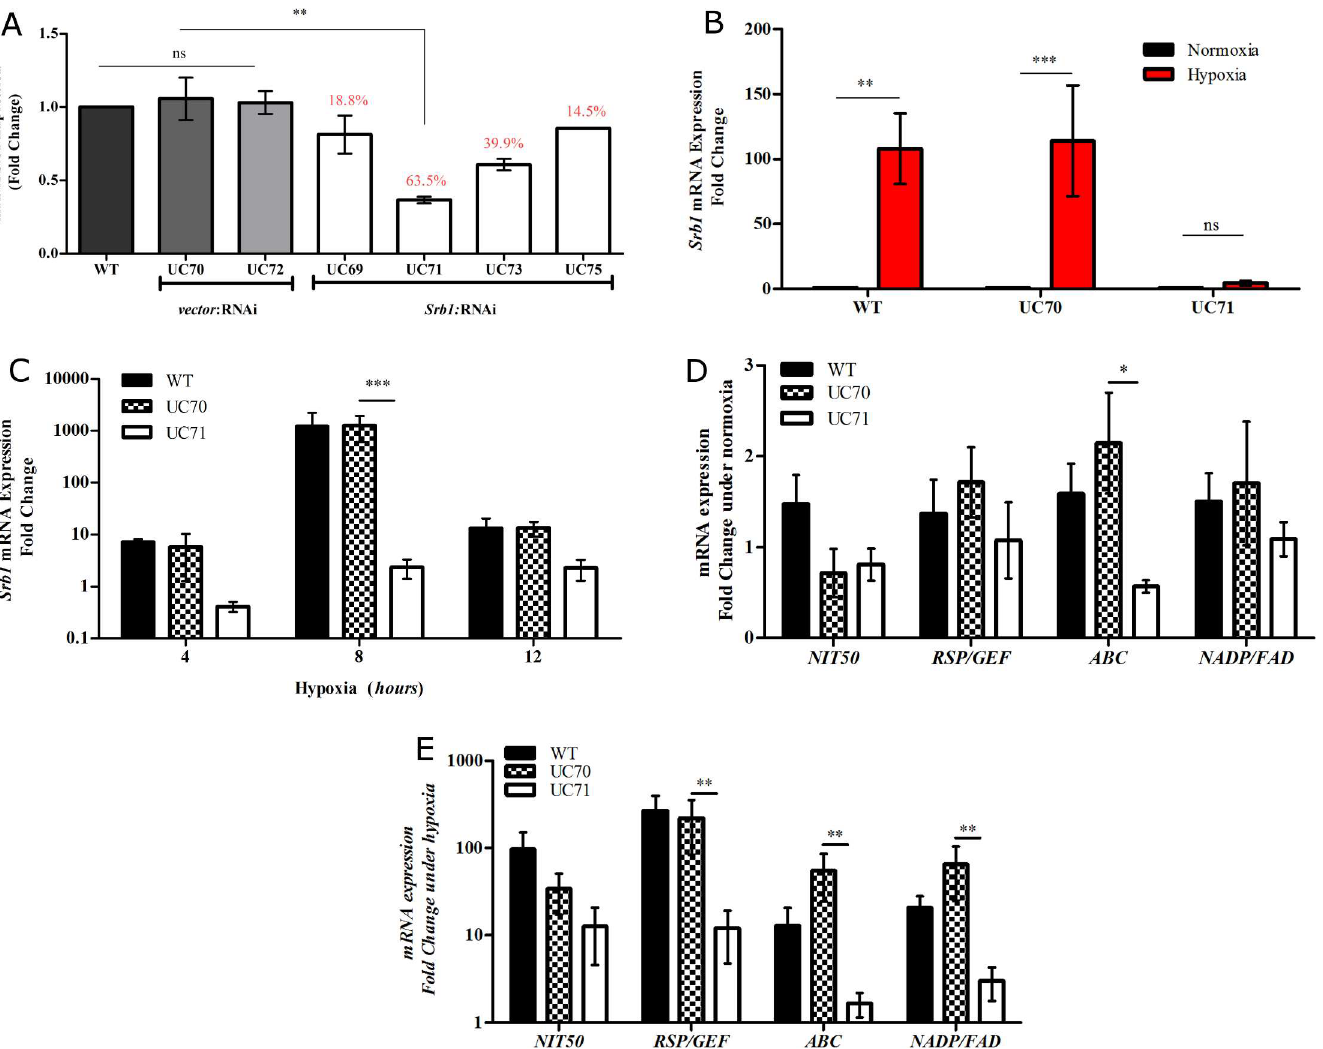
Fig 1. RNAi triggers effective silencing Srb1 in H . capsulatum . ( A) . Quantitative RT-PCR analysisof Srb1 demonstrates a 14.5% to 63.5% reduction in Srb1 transcript levels in characterized Srb1 -RNAi strains, but no reduction in wild-type-vector strains. RNA was extracted from yeast grown in normoxia for 72 hours. (B) Srb1 expressionis not induced after 8 hours of hypoxia in Srb1 silenced H . capsulatum , UC71 ( Srb1 :RNAi), compared to wild-typeand wild-type-vector strain, UC70 ( vector :RNAi). RNA was extracted from yeast grown under hypoxia for 8 hours. (C) Srb1 expression remained at basal levels after 4, 8 and 12 hours of hypoxia when Srb1 is silenced. RNA was extracted from yeast grown in hypoxia for 4, 8 or 12 hours. (D) ABC and RSP/ GEF expressionis significantlylower in UC71 ( Srb1 :RNAi) comparedto WT and UC70 ( vector :RNAi) under normal atmospheric conditions. RNA was extracted from yeast grown in normoxia for 72 hours. (E) ABC , RSP/GEF , NADP/FAD expression are not significantly induced in UC71 ( Srb1 :RNAi) after 8 hours of hypoxia. RNA was extracted from yeast grown in hypoxia for 8 hours. For all panels above RNA was extracted from wild type and silenced strain yeast grown under conditionsdescribed. Transcript levels were normalized to the constitutively expressedGAPDH gene. Data are represented as the mean ± standard error mean (SEM) of 3–4 experiments (Panel A) and 2–3 experiments (Panels C-E).